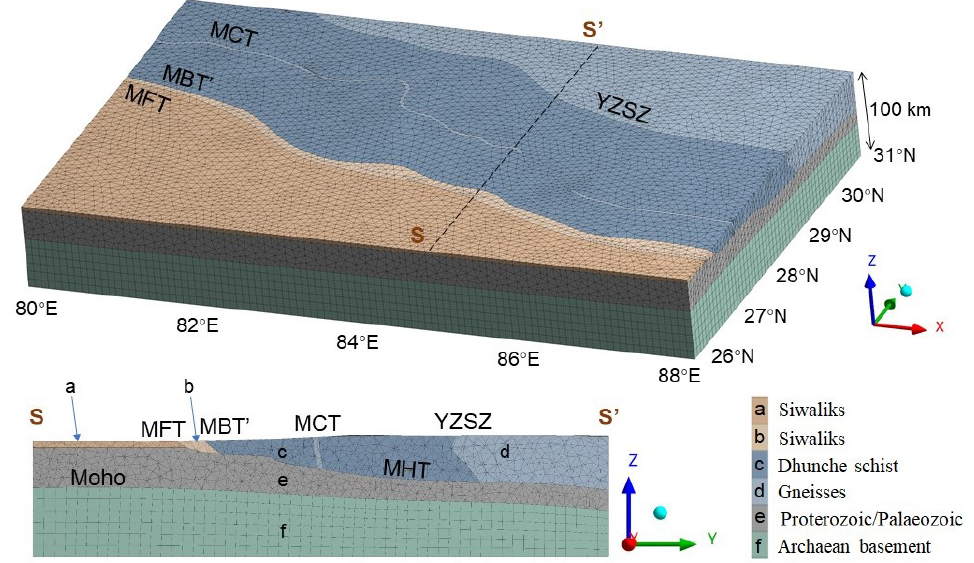
Figure 5. 3D geometrical model of geological structure in Nepal and its nearby areas. MFT, MBT (cid:48) , MCT, and MHT mean the same as before, while YZSZ means Yarlung Zangbo suture zone. The X axis is west–east, the Y axis is south–north, and the Z axis is bottom–top. For each domain, the density values ( ρ) , Young’s Modulus ( E) , and Poisson’s ratio ( ν) were reported as ρ = 2550kgm − 3 , E = 20GPa, and ν = 0 . 25 in strata a and b; ρ = 2700kgm − 3 , E = 40GPa, and ν = 0 . 25 in strata c and d; ρ = 2700kgm − 3 , E = 70GPa, and ν = 0 . 25 in strata e; ρ = 2700kgm − 3 , E = 170GPa, ν = 0 . 25, and coefficient of viscosity = 10 20 Pas − 1 in strata